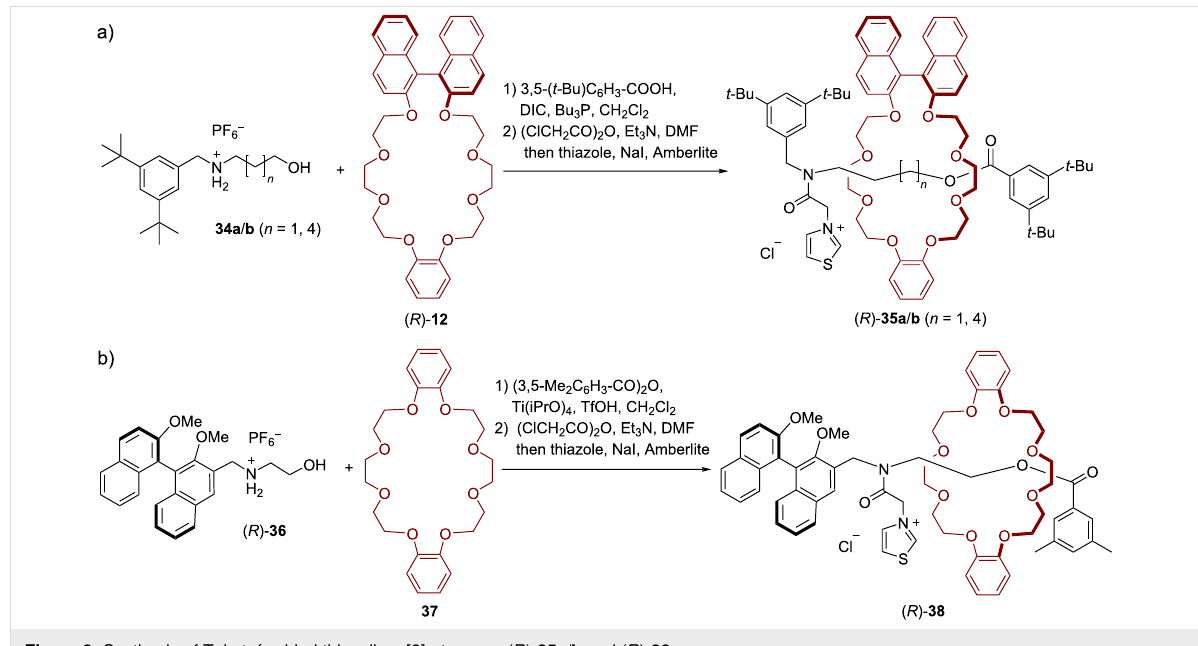
Figure 8: Synthesis of Takata´s chiral thiazolium [2]rotaxanes ( R )- 35a / b and ( R )- 38